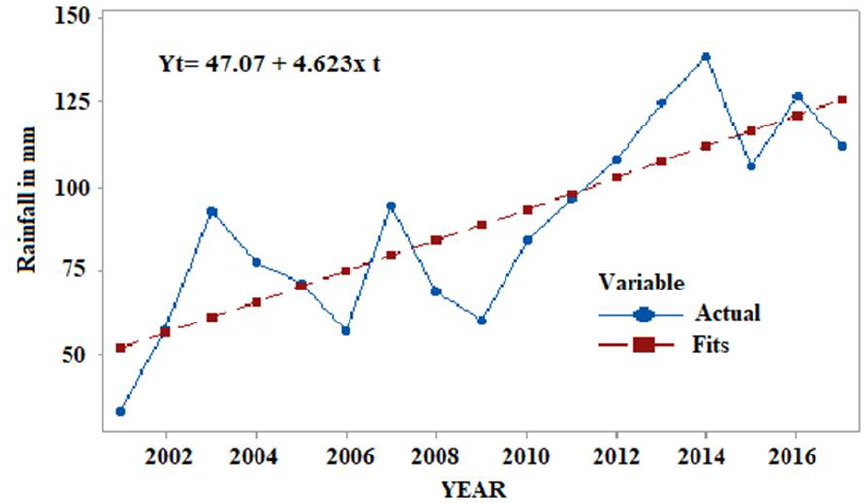
Figure 2. Trend of mean annual rainfall in the upper Tana Basin upstream of Garissa river gauging station between 2000 and 2016.